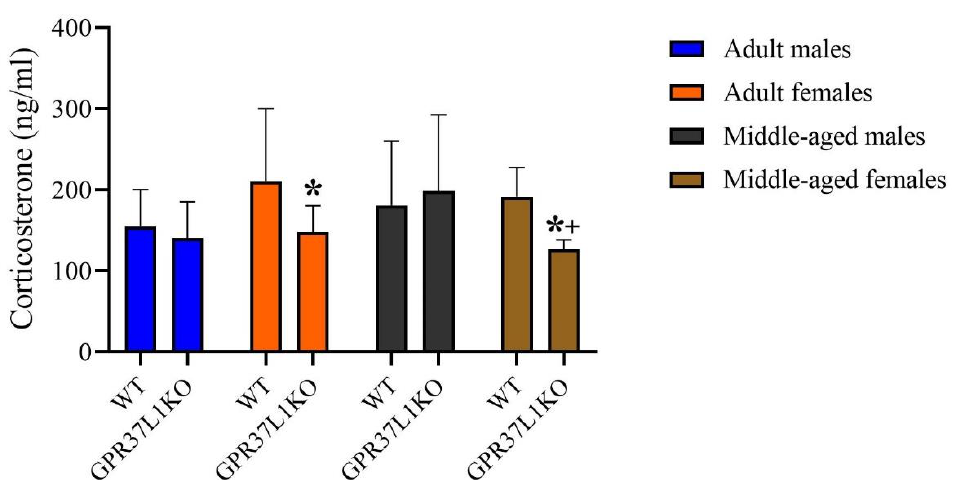
Figure 6. Effect on the level of circulating corticosterone in adult and middle-aged WT and GPR37L1KO males and females after PAT. n /group: 5 to 10. All data represent mean ± SD. * p < 0.05 within genotype; + p < 0.05 with respect to sex calculated by three-way ANOVA, followed by multiple comparisons using the two-stage linear step-up procedure of Benjamini, Krieger and Yekutieli.